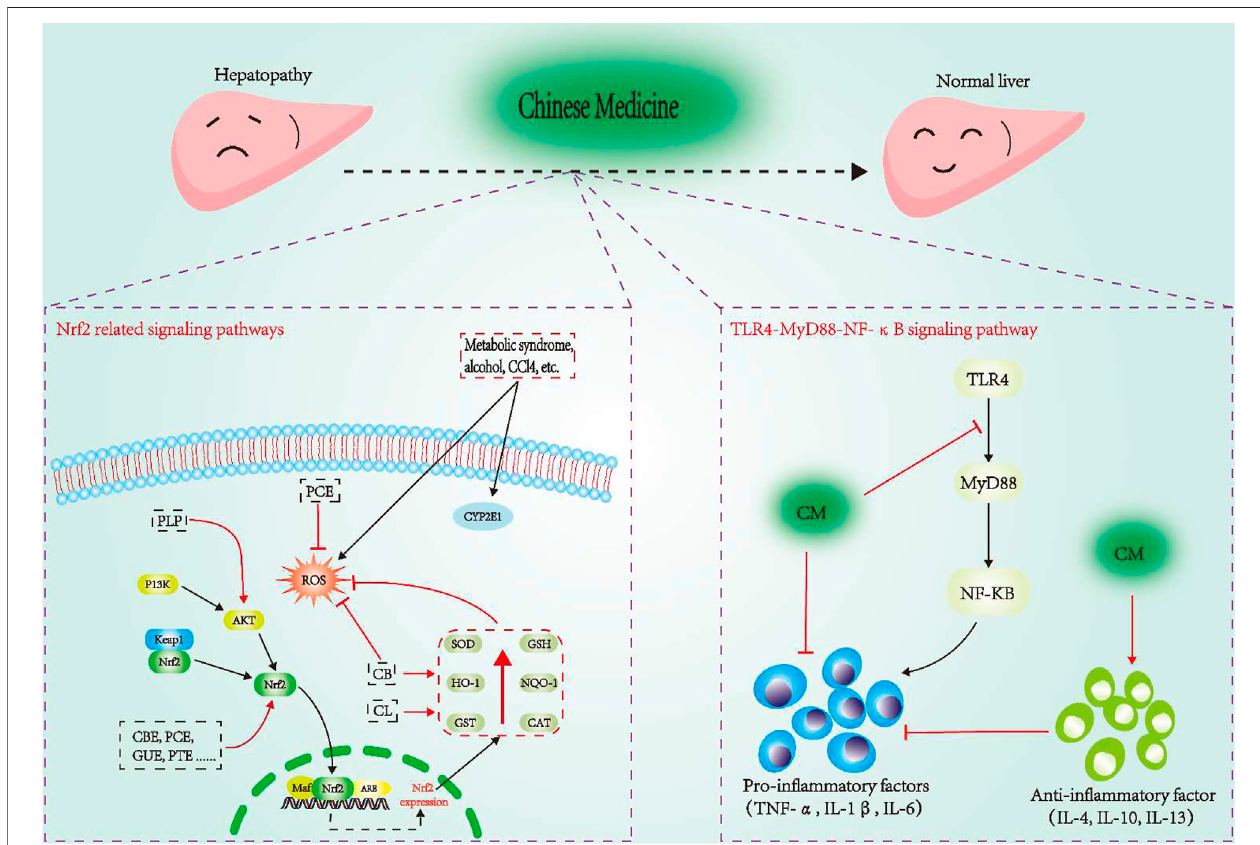
FIGURE 4 | Some CM treat liver disease through Nrf2 and TLR4-MyD88-NF- κ B signaling pathway. CBE, Citrus reticulata Blanco peel extract; GUE, Glycyrrhiza uralensisethanolextract;PTE,Polygonummulti fl orumThunb.ethanolicextract;PLP,Paeonialacti flfl oraPall.;CL,Curcumalonga;CB,Calculusbovis;PCE,Polygonum cuspidatum